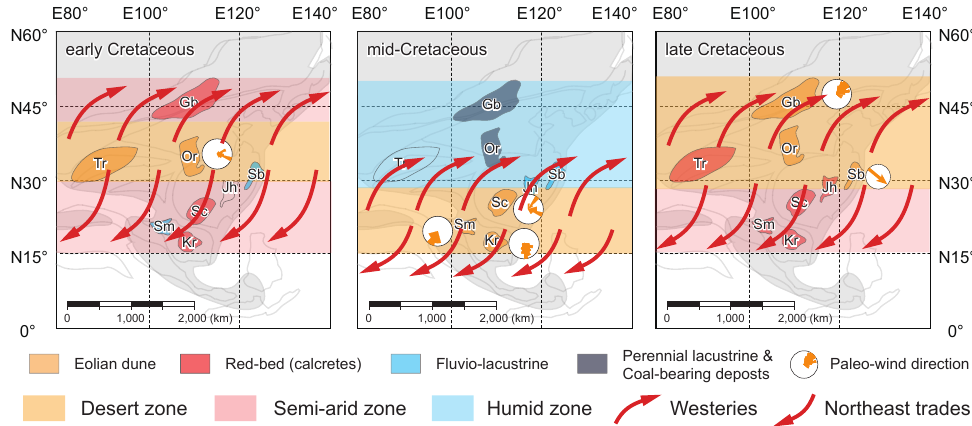
Fig. 2. Spatio-temporal changes in the distribution of climate-indicative sediments and paleo-wind directions in the Asian interior during the early, mid-, and late Cretaceous. The distribution of the reconstructed subtropical arid zone (yellow-colored desert zone and red-colored semi-arid zone) shows marked changes in latitude through the Cretaceous. The paleo-wind directions, plotted on rose diagrams, also indicate drastic shifts in the boundary position of the westerlies and northeast trade winds in Asia. Based on the paleo-wind direction data, together with the latitudinal distribution of deserts in the Asian interior, the divergence axis of the subtropical high-pressure belt is estimated to have been situated between 30 ◦ N and 40 ◦ N during the early and late Cretaceous, and between 20 ◦ N and 30 ◦ N during the mid-Cretaceous. The original data regarding depositional ages, paleolatitudes, and paleo-wind directions in each basin are shown in Fig. 1 and Table